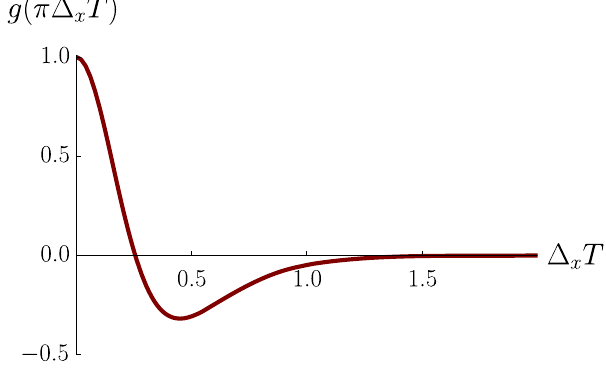
T Þ for the fermion FIG. 5. Dimensionless function g ð π Δ x braiding correction to the thermal conductance against temper- ature T and pinch separation Δ (or braiding path length differ- x T ≫ 1 , this correction ence 2 Δ ) in a two-pinch geometry. For Δ x x T Þ is exponentially suppressed; in the opposite limit, g ð π Δ x exhibits a quadratic deviation away from